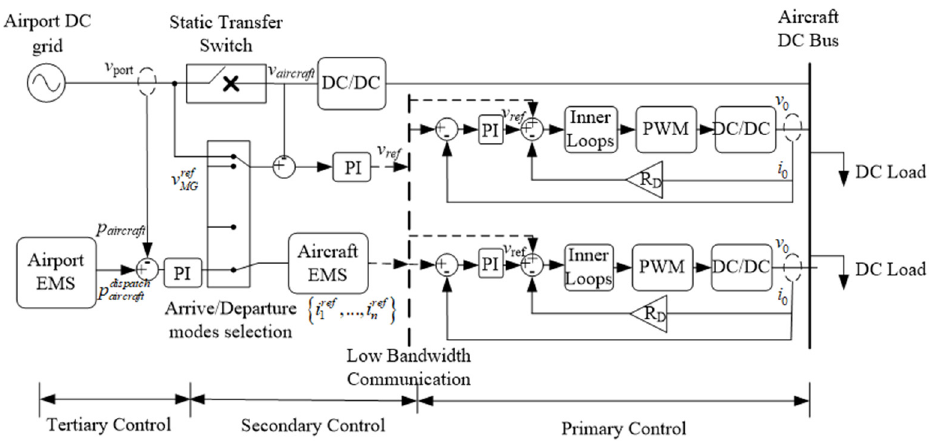
Figure 20. The power control loop architecture between airport and electrical propulsion aircraft.